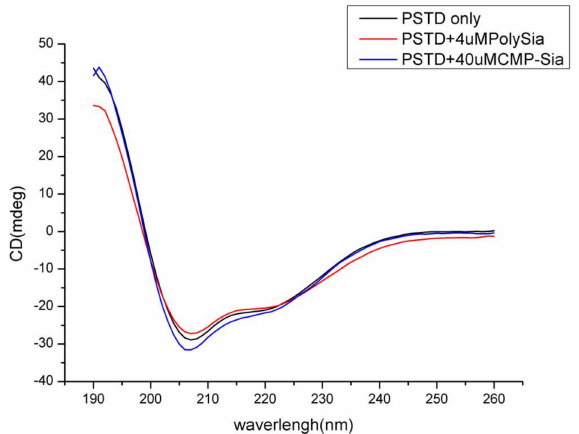
Figure 3. Circular dichroism (CD) spectra of the PSTD peptide from ST8Sia IV in the absence and presence of sialic acid (Sia), cytidine monophosphate-sialic acid (CMP-Sia) and polysialic acid